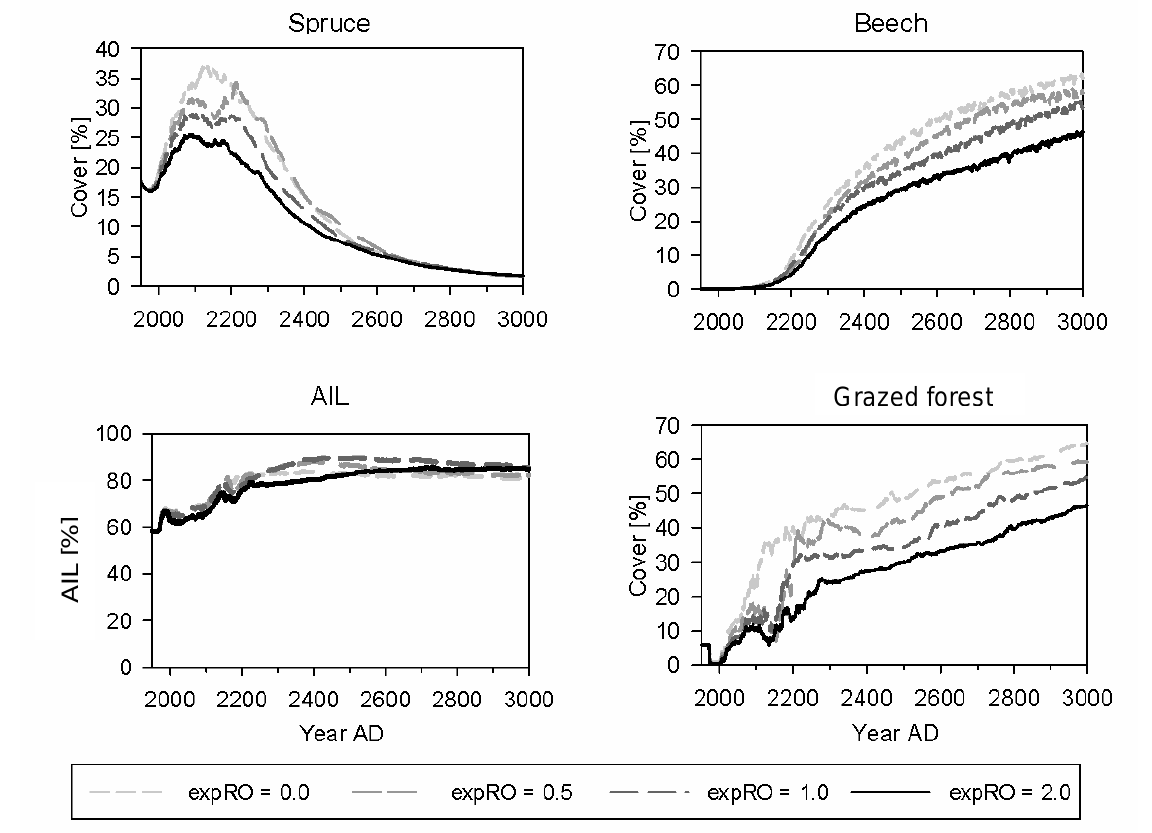
Figure A1: Population dynamics of spruce and beech and corresponding landscape structural dynamics for varying strength of the effect of shallow soils on drought stress for trees. All simulations are performed in the mountain pasture Pré aux Veaux along the moderate climate change scenario B2. The AIL is the landscape structure aggregation index (see main text) with high values indicating a homogeneous